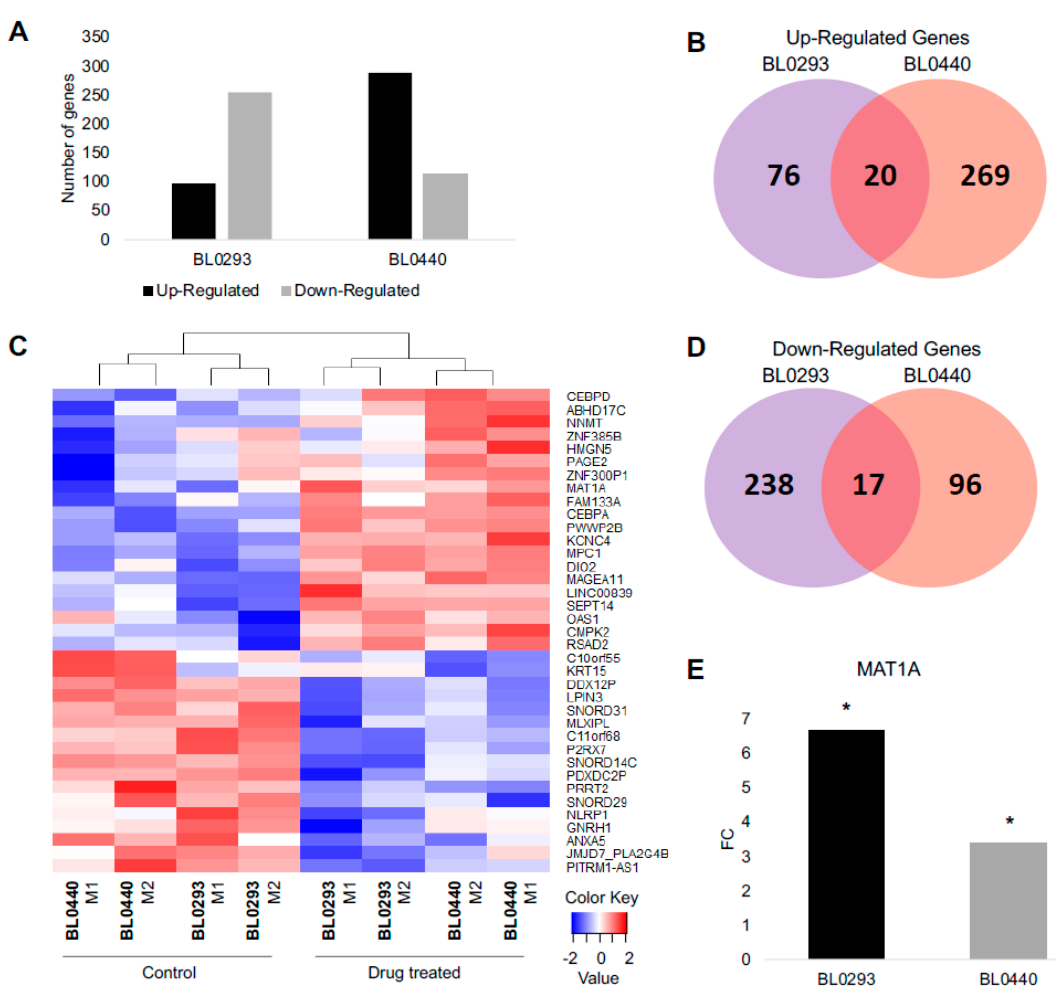
Figure 2. RNA sequencing (RNA-seq) profiling identifies significant transcriptional changes in drug treated bladder PDX tumors. ( A ) 351 and 402 genes were found significantly changed in BL0293 and BL0440 drug-relapsed tumors; ( B ) 20 up-regulated and ( D ) 17 down-regulated genes where shared by both drug-relapsed xenografts. ( C ) A heat map depicts variation of shared up- and down-regulated genes among BL0293 and BL0440 biological replicates. M1 and M2 denote biological replicates. ( E ) methionine adenosyltransferase 1a ( MAT1A ) gene expression values in sensitive (PBS) and drug treated (Rx) tumors from RNA sequencing data, expressed in fold change (FC), for both BL0293 and BL0440.